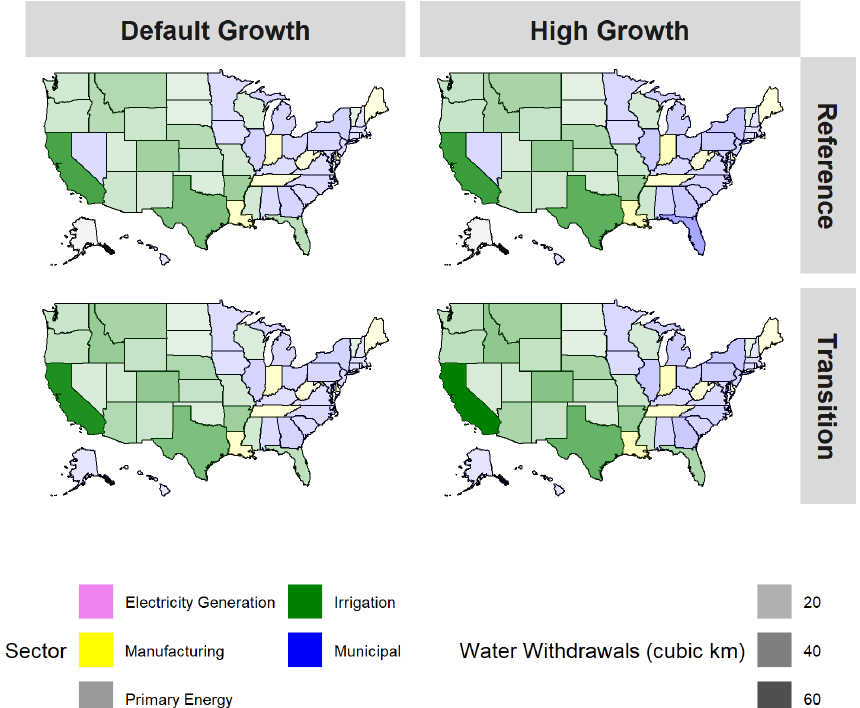
Figure 8. Water withdrawals by state and scenario in 2100. Fill color represents the sector with the largest water withdrawals in each state. Shading (transparency) corresponds to the magnitude of total withdrawals (sum of all sectors) by state. Columns reflect alternate assumptions about socioeconomic drivers; rows represent alternate assumptions about energy system